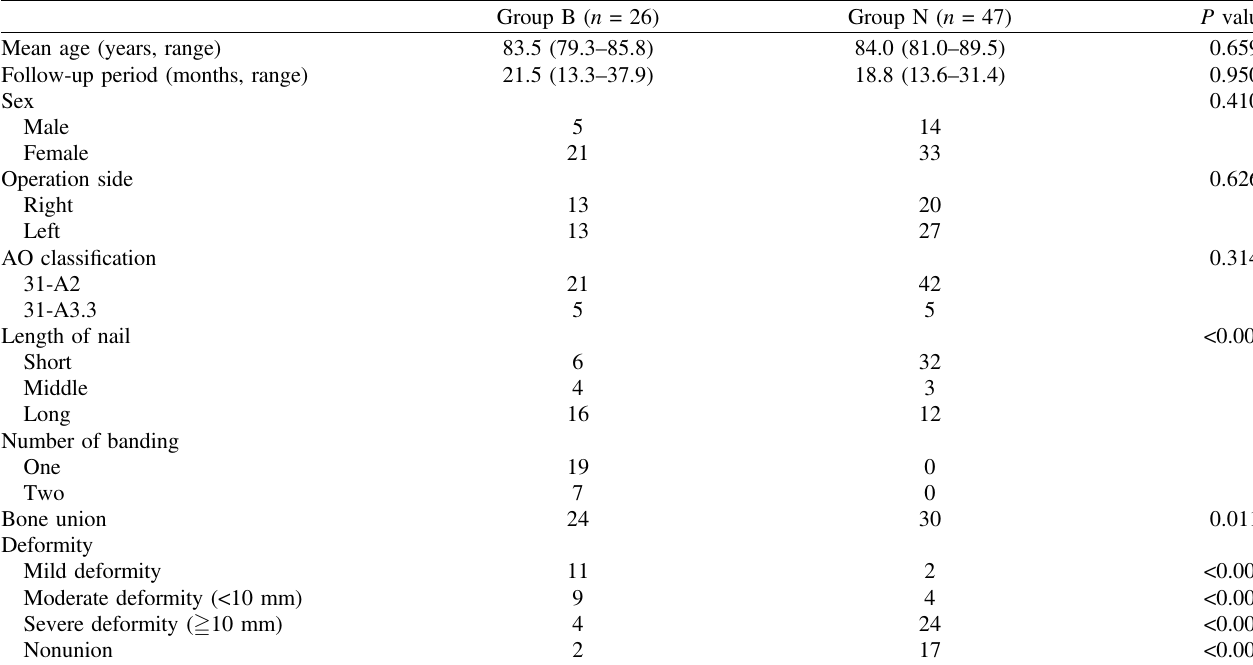
Table 1. Background of